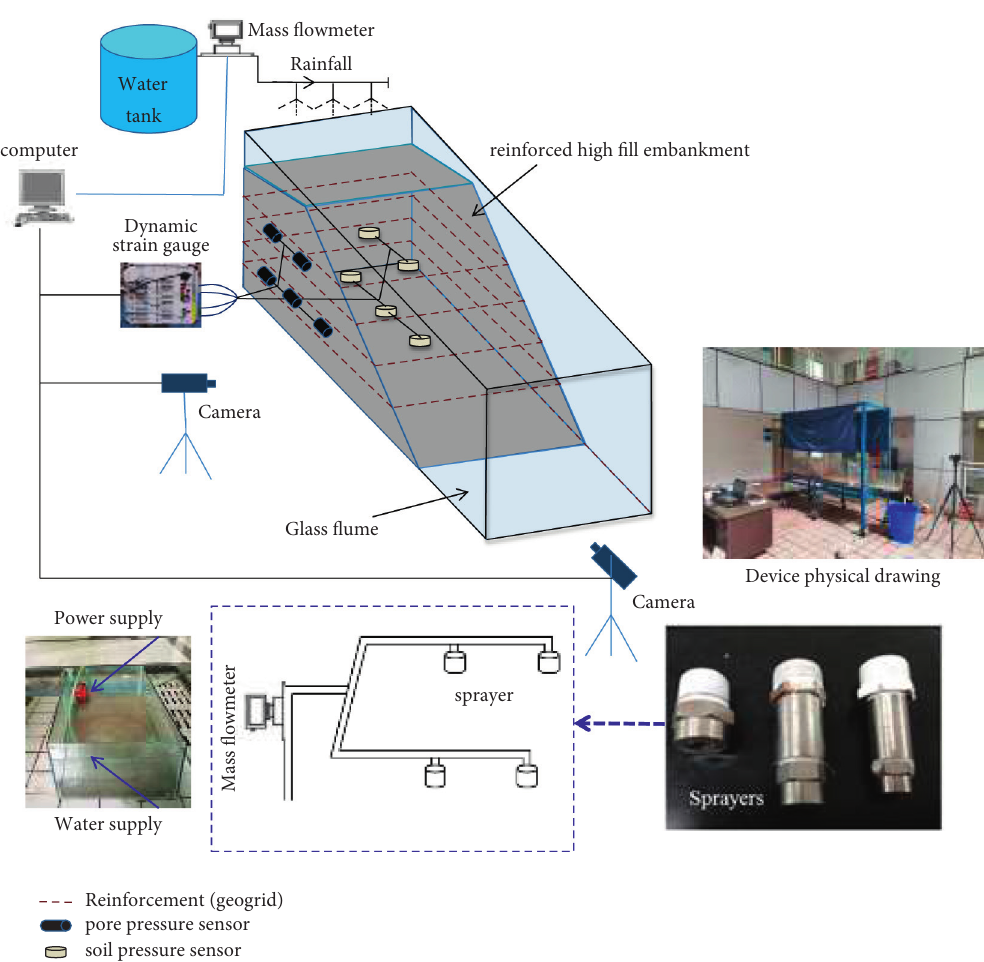
Figure 1: Rainfall test system for reinforced artificial high embankment. Table 1: The basic property of reinforcement.